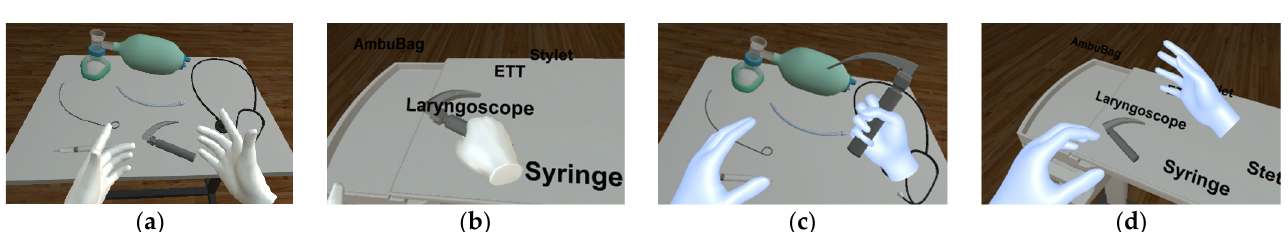
Figure 3. Introduction scene, pick up and drop the equipment according to its name: ( a ) virtual hand of the controller; ( b ) selection with controller; ( c ) selection with hand (grabbing); ( d ) release (unhand).